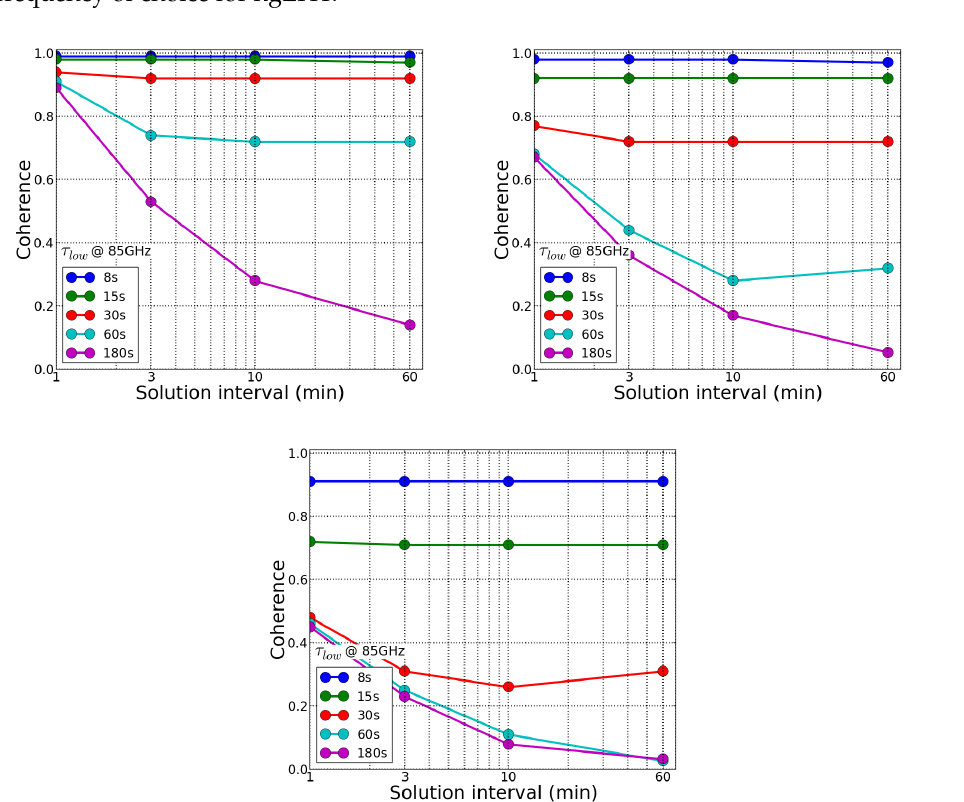
Figure 3. Expectations for FPT Coherence at 340 GHz band under Very Good ( left ) and Good ( right ) and Tolerable ( bottom ) weather conditions, after calibration with simultaneous 85 GHz band observations, for a range of integration times up to 60 min. Different colors are for different calibration timescales at 85 GHz (i.e., τ low ) as listed in the inset: 8 s (dark blue), 15 s (green), 30 s (red), 60 s (cyan) and 180 s (magenta). Sustained coherence of 0.9 or better can be obtained with calibration timescales of 30, 15 and 8 s, respectively. In very good weather coherence of 0.7 is obtained even with a 1 min calibration cycle, and similar levels of coherence can be achieved with a 30s calibration cycle in good weather. Even in tolerable weather similar coherence is achievable with a fast 15 s τ low